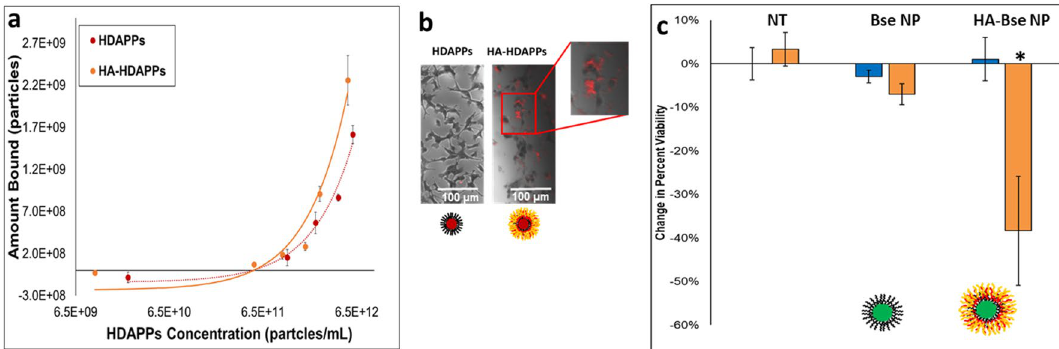
Figure 3. Targeted HDAPPs/BSe NP activity in 2D in vitro culture. ( a ) Fluorescent HA-HDAPPs display an increased binding profile to CT26 cells compared to HDAPPs. ( b ) Qualitative confirmation of HA-HDAPPs binding using by fluorescent imaging registered to the brightfield images of CT26 cells. ( c ) Reduction in the percent of viable cells indicates that only targeted HA-BSe NPs were capable of inducing ablation under laser stimulation. (Error bars reported as